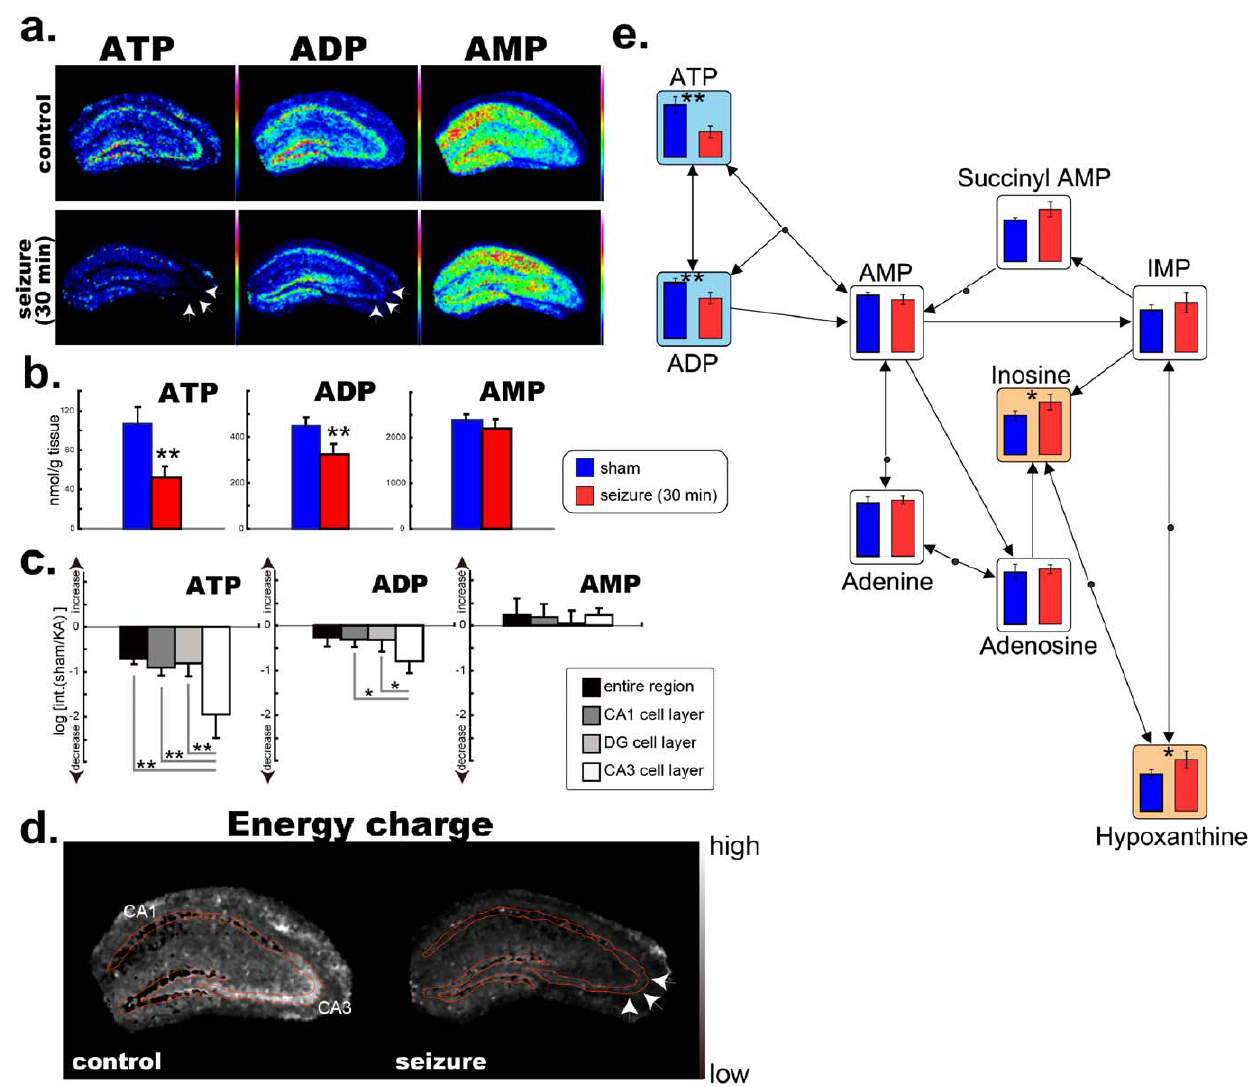
Figure 1. CA3 cell-selective consumption of ATP and ADP during a kainate-induced seizure. a . MALDI imaging of adenosine nucleotides in a mouse hippocampus. b . Absolute quantification of ATP, ADP, and AMP in a mouse cerebrum using CE-MS. Massive reductions in the levels of ATP and ADP, but not AMP were observed during kainate-induced seizures. (n=4 mice for each group; * p , 0.05, ** p , 0.01; Welch’s t -test). c . Results of the relative quantification of ion intensity for ATP, ADP, and AMP calculated from the averaged mass spectra of each hippocampal sub-region obtained using MALDI imaging. The values shown are logarithmic ratios of ion intensities between sham-operated (sham) and kainate-treated mice (KA). (n=4 mice for each group; * p , 0.05, ** p , 0.01; Welch’s t -test). d . Mapping of energy-charge index values on tissue sections. The region-specific reduction of these values in the CA3 region (arrows) suggests massive energy metabolism in CA3 neurons. e . Relative quantitative comparison of adenosine nucleotides and related metabolites using CE-MS. Each result is mapped on the metabolic pathway and clearly shows the depletion of ATP and ADP due their conversion into downstream metabolites. Colored graphs indicate significant increases (orange) and decreases (blue). (n=4, * p , 0.01, ** p , 0.05; Welch’s t